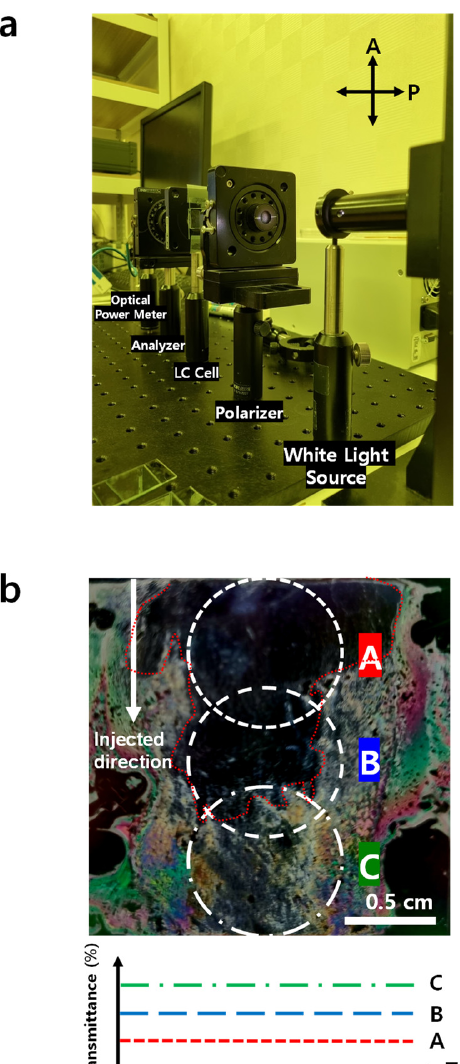
Figure 3. ( a ) Experimental setup image to evaluate Optical transmittance. Cross-polarization is set for testing the homeotropic alignment. ( b ) Overall image with insufficient [HTAB] for fully-vertical alignment (Cell gap = 10 µ m, [HTAB] = 0.01 wt%). White dotted line: area where white light is applied to the sample. Lower graph: transmittance non-uniformity caused by insufficient [HTAB].